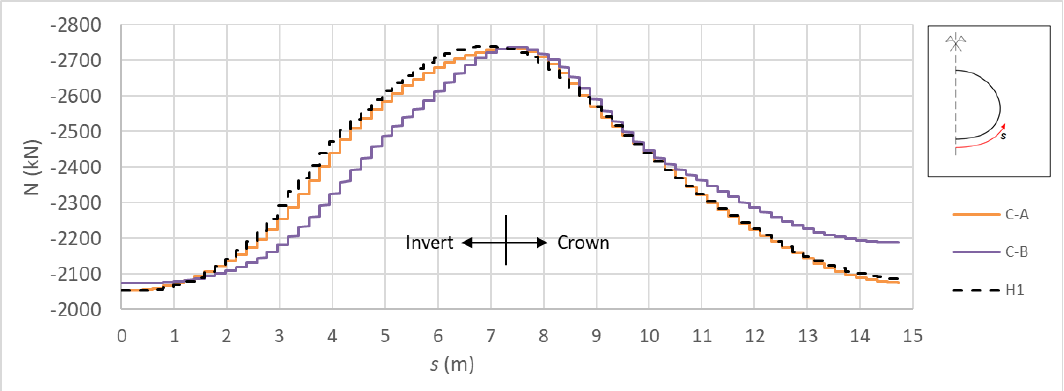
Figure 2. Comparison of axial force beam load results for varying complexity of calibrated